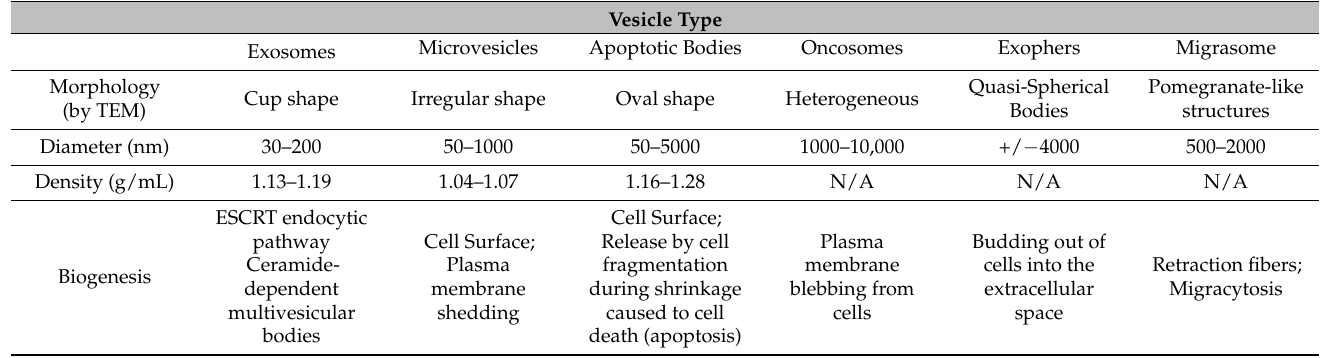
Table 1. Detail classification and characteristics of EV populations (modified based on